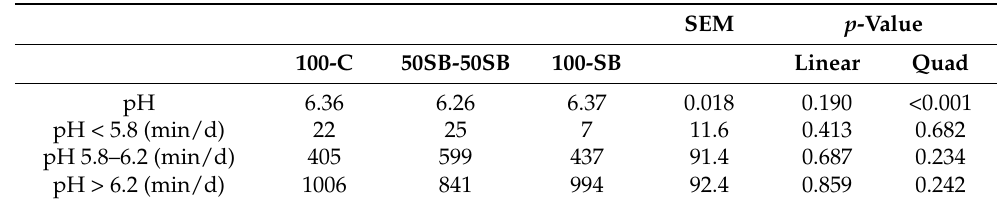
Table 5. The effects of replacing ground corn with sugar beet root on the rumen pH of early-lactating dairy